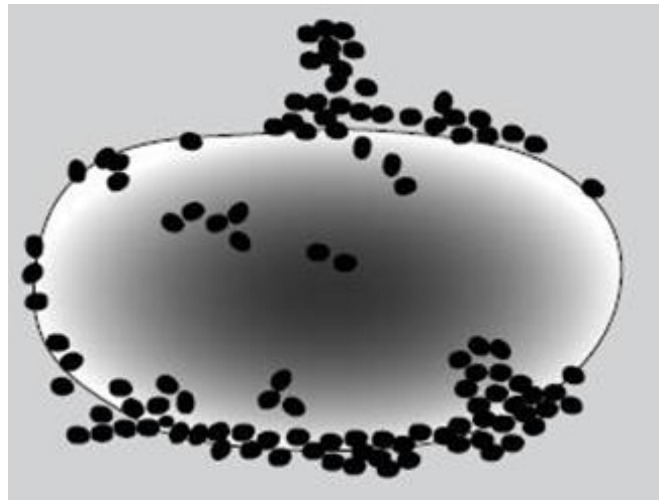
Figure 8. Graphic representation of gold nanoparticles binding to the surface of a target cell.